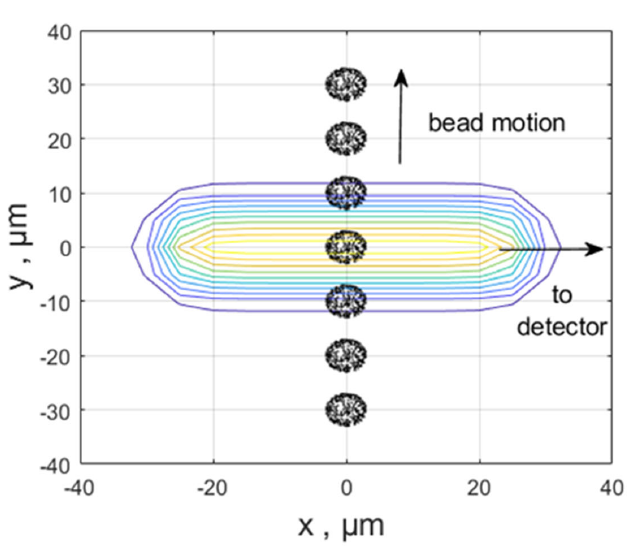
Figure 3. The black spheres show seven consecutive positions of a bead traversing the laser beam. The ellipsoids centered on the origin show a contour plot of a laser with a flat-top beam shape. Each of the bead images was obtained by simply adding or subtracting 10 × 10 − 6 m to/from the y -coordinate of the bead originally defined relative to the same origin as the center of the laser beam. The total illumination was calculated by adding the illuminations of each label on the bead. The illumination calculation was performed by inserting the array of bead coordinates (after modification of the y ‐ coordinates) into the flat ‐ top function describing the laser beam intensity. The total illumination was calculated by adding the illuminations of all labels in the bead bead’s y ‐ coordinate at − 30 × 10 − 6 m relative to the beam center (the intersection of the laser